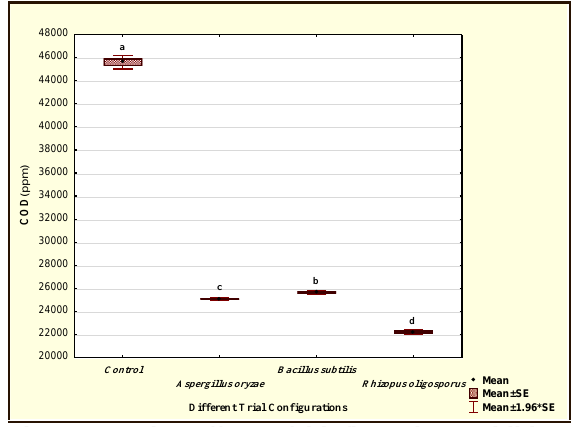
Figure. 4. The effect of bioflocculant ‎ addition on COD content of dairy wastewater The same letter illustrates lack of significant difference at the 0.01 probability